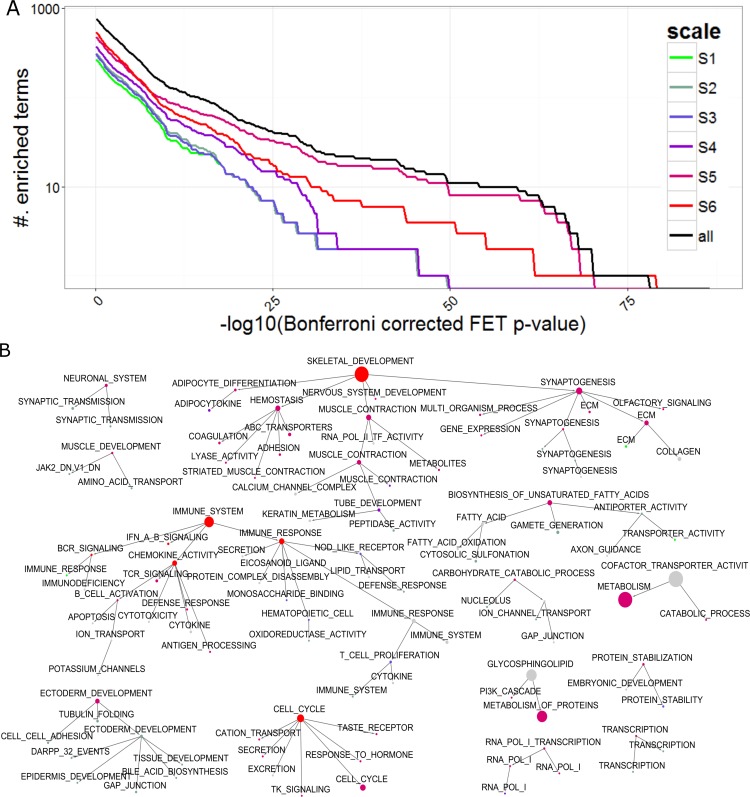
Hierarchical organization of functions and signaling pathways corresponding to the multiscale clusters identified by MEGENA.A) Comparison of number of significantly enriched functions and pathway signatures across clusters identified at different scale groups. The scale groups identified from MHA are colored according to the legend, and “all” denotes collection of clusters across the scale groups. B) Multiscale organization of clusters in PFN. Each node is a cluster identified by multiscale clustering in PFN, where the node size is proportional to the cluster size, node color coincides with the cluster group color scheme in A, and node labels indicate most enriched function/signaling pathway for individual clusters. A directed link a→b indicates b is a sub-cluster of a.